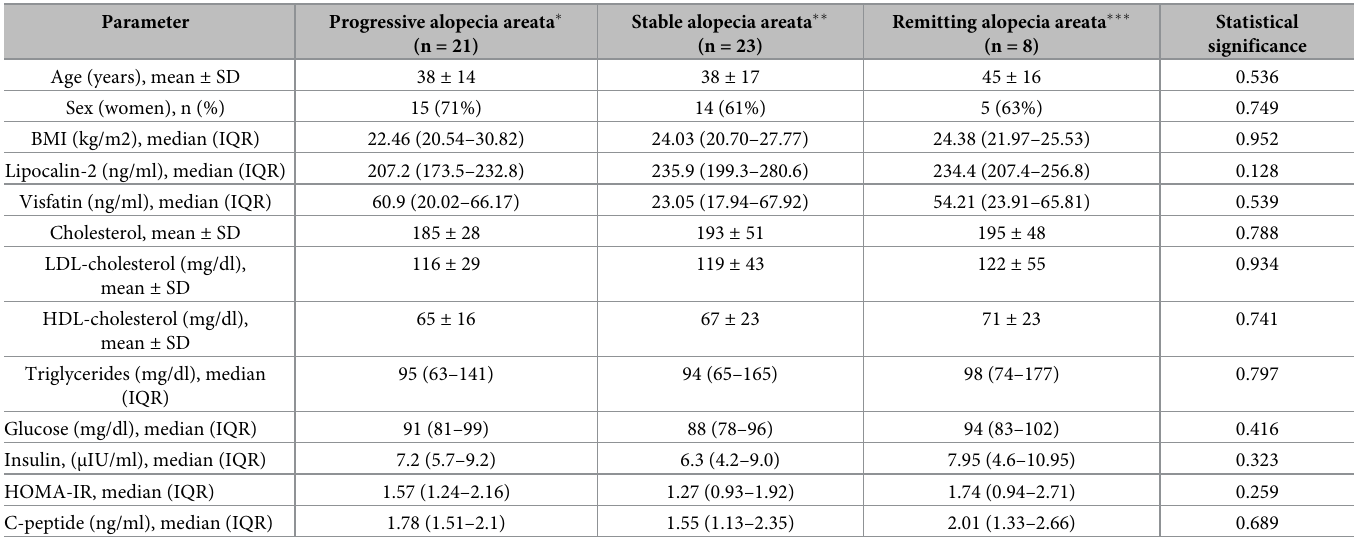
Table 6. Selected clinical and laboratory parameters in patients with progressive, stable and remitting alopecia areata.